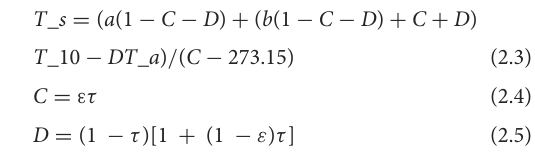
algorithm, single-channel algorithm, radiative transfer equation algorithm and so on. Among which, the radiative